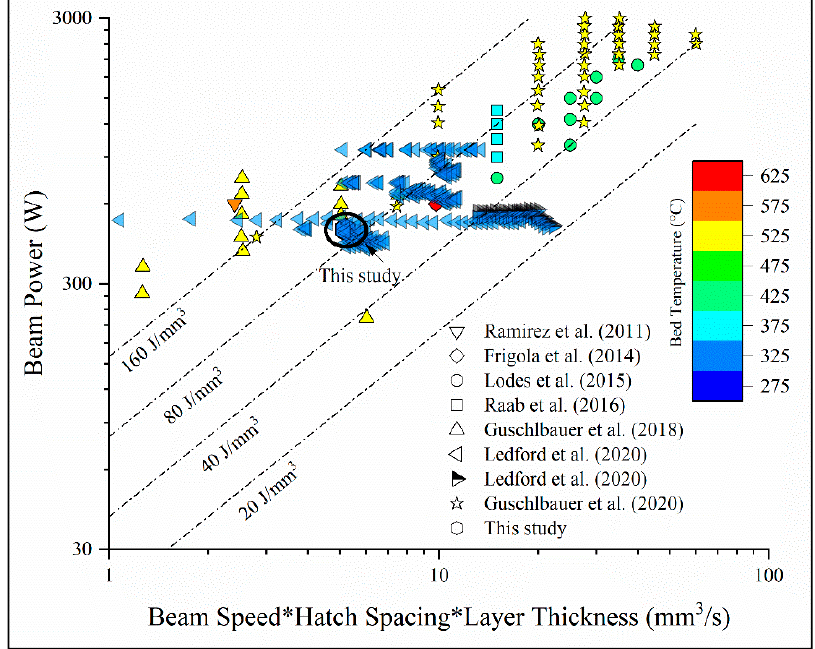
Figure 4. Processing space of EB-PBF fabrication of unalloyed copper by taking the process parameters used in the literature. Major observations of such studies are highlighted along with reported solid densities in Table 1.